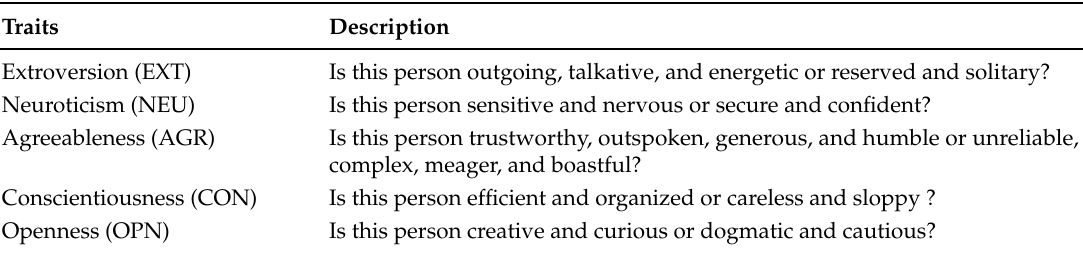
Table 1. Description of the Big Five personality